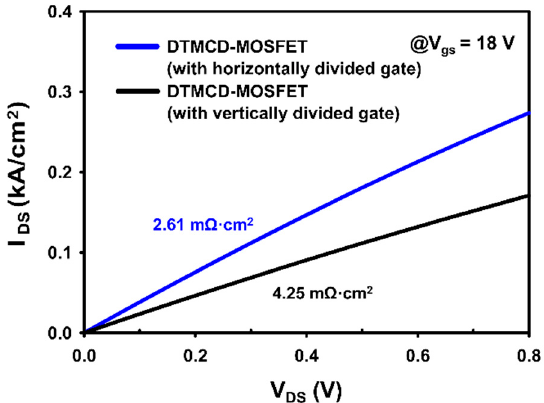
Figure 5. Cross-sectional view of electron current density distribution of ( a ) proposed DTMCD- MOSFET with horizontally separated gate structure and ( b ) DTMCD-MOSFET with vertically sepa- rated gate structure.